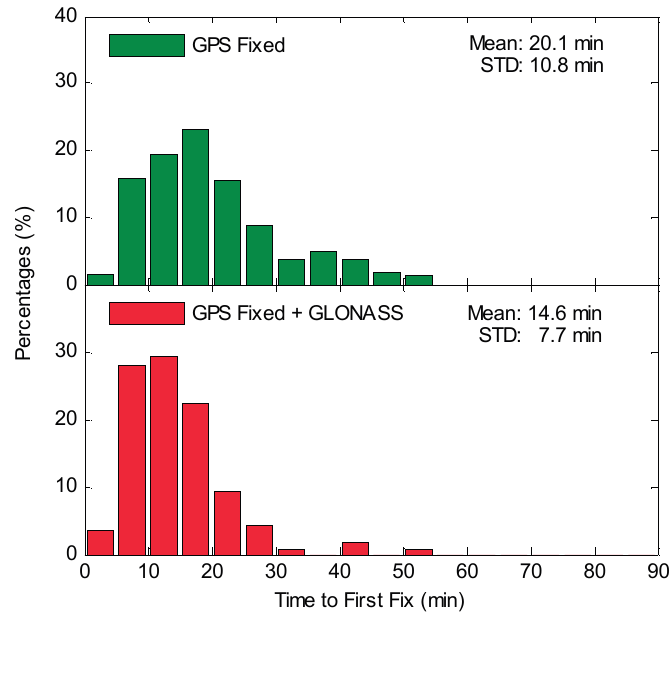
Figure 10. Distributions of time to first fix (TTFF) for GPS-only ambiguity-fixed PPP and GGPPP-FGA processing in eight sessions using datasets collected at 20 IGS stations on two consecutive